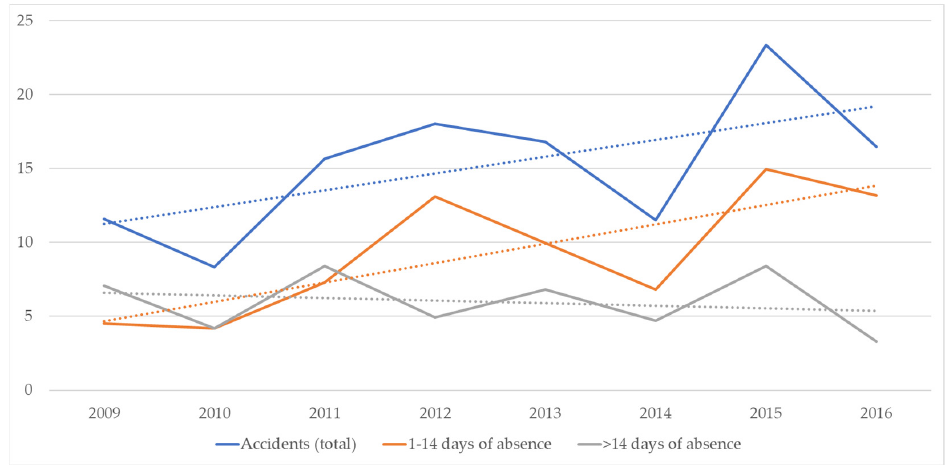
Figure 13. Incidence rates in floor and wall covering. Based on data from [17 – 24,27] .